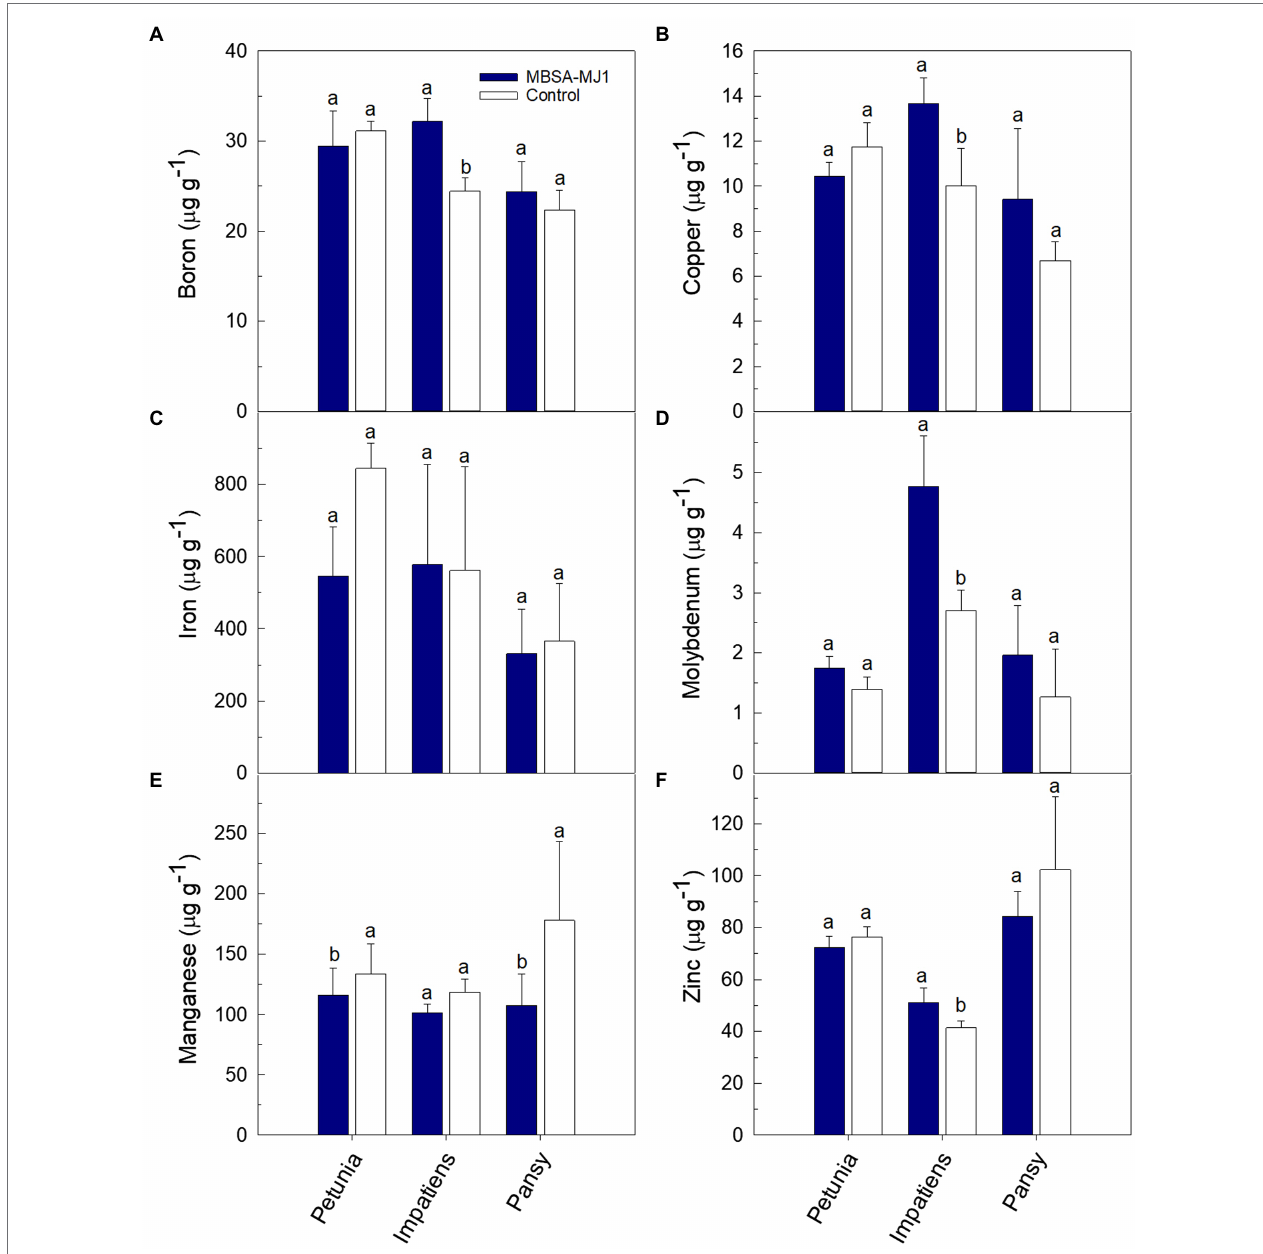
FIGURE 4 | Tissue micronutrient concentration of Petunia × hybrida (petunia), Impatiens walleriana (impatiens), and Viola × wittrockiana (pansy) plants grown under low-nutrient conditions: boron (A) , copper (B) , iron (C) , molybdenum (D) , manganese (E) , and zinc (F) . Plants were treated weekly with a media drench of S. plymuthica MBSA-MJ1 (blue bars) or uninoculated LB (control; white bars). Tissue nutrient concentration was evaluated 8 weeks post-transplant. Bars represent the mean (±SE) with different letters representing significant differences ( p < 0.05) and n =